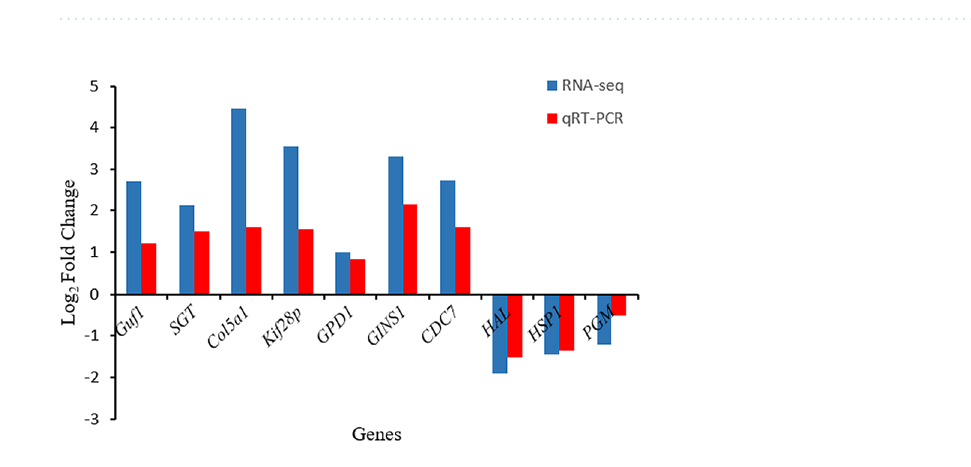
Table 2. Annotated associated genes, difference multiples, and GO entries.